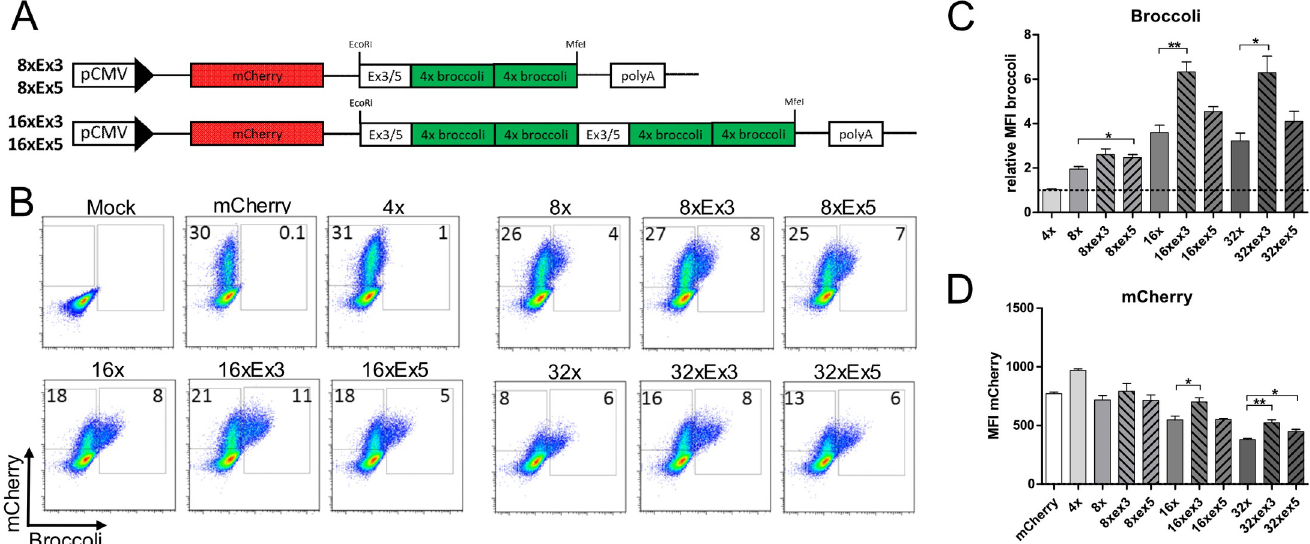
Fig 7. Expression profile of Broccoli tandem constructs with exonic inserts. (A) Cloning schematic of Broccoli with inserted exonic sequences, exon 3 or exon 5, from GAPDH gene of NIH-3T3 cells. (B, C, D) Flow cytometry data of 293T cells transfected with the different plasmids, collected and analysed 24 hours post- transfection. Comparison between the plasmids in regard to percentage of Broccoli and mCherry positive cells (B), mean fluorescence intensity of Broccoli (C) and mean fluorescence intensity of mCherry (D). (C) The values shown were normalized to the cells transfected with 4xBroccoli plasmid. Statistical analysis performed by t-test (C, D). � P < 0.05, �� P < 0.01.